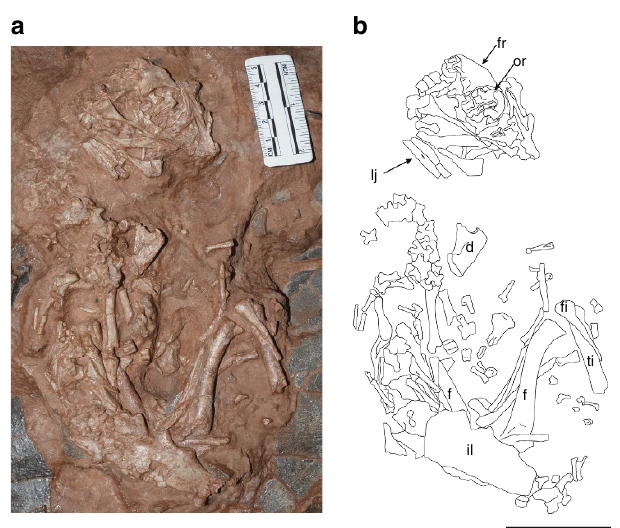
Figure 2 | Skeleton of Beibeilong sinensis (HGM 41HIII1219). ( a ) Photograph. ( b ) Highly schematic outline shows general layout of the skeleton (illustrated by Zhaochuang). Scale bar, 5cm. d, dentary; f, femur; fi, fibula; fr, frontal; lj, lower jaw; or, orbit; ti,